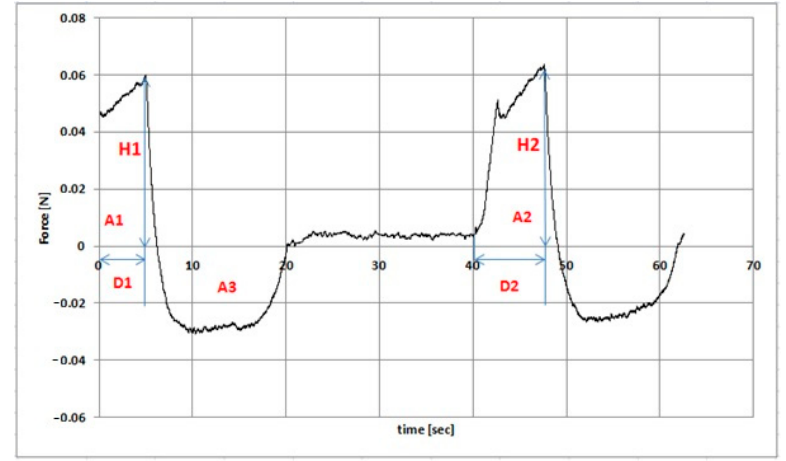
Figure 3. Example of texture profile analysis with parameters (the symbols are discussed in the text).